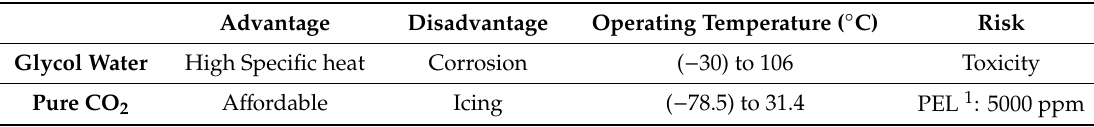
Table 1. Characteristics of the refrigerant media.